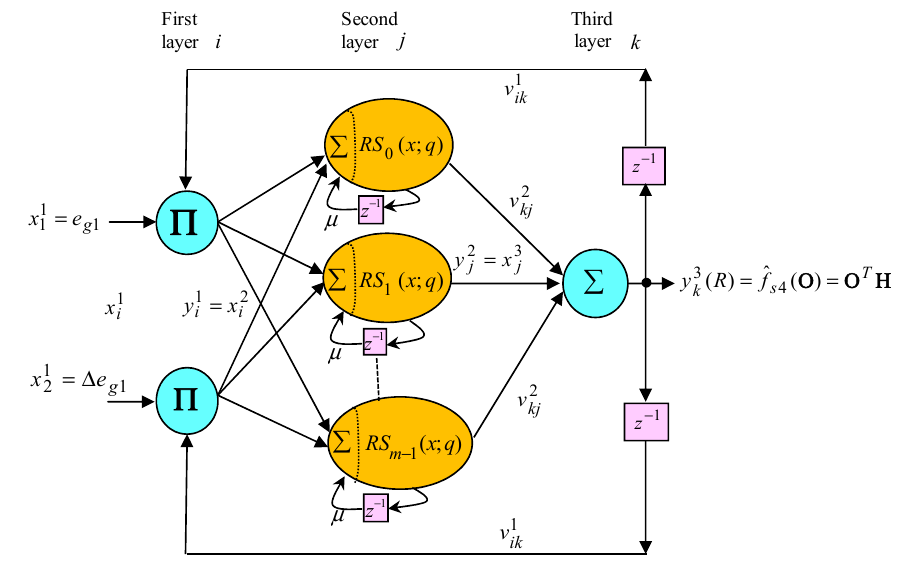
Figure 4. Constitution of the MRRSPNN.